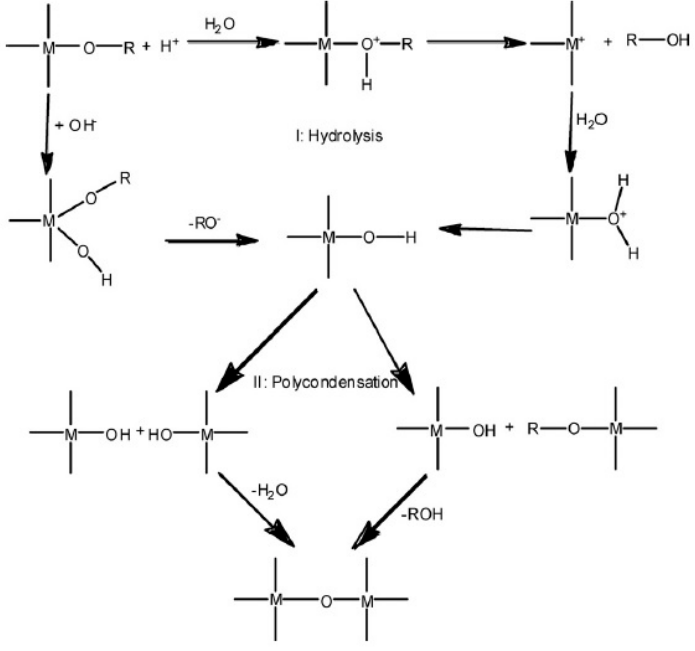
Figure 2. Schematic of the two-step sol–gel reaction routes for metal alkoxides [16]. Copyright 2011, reproduced with permission from Elsevier